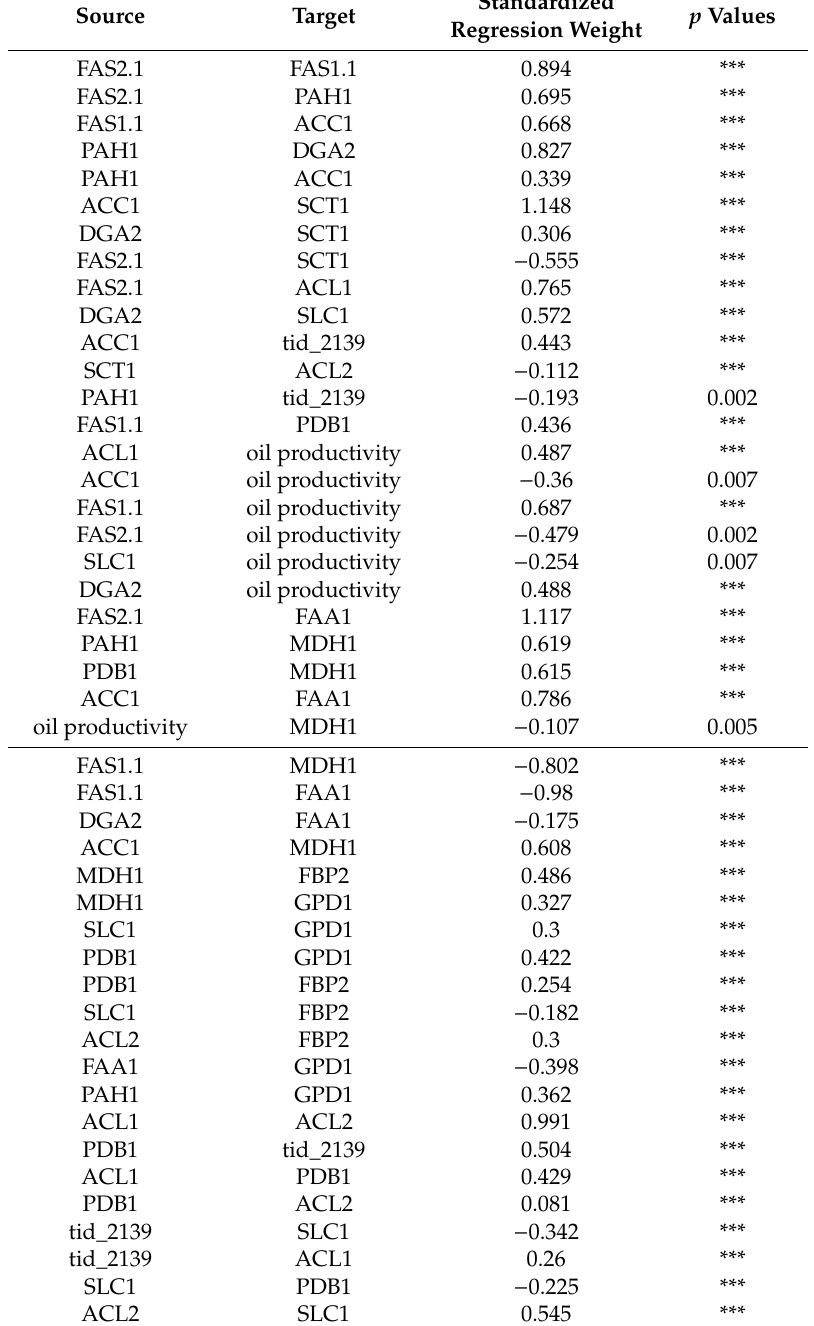
Table 3. Estimated regulations and regression weights.